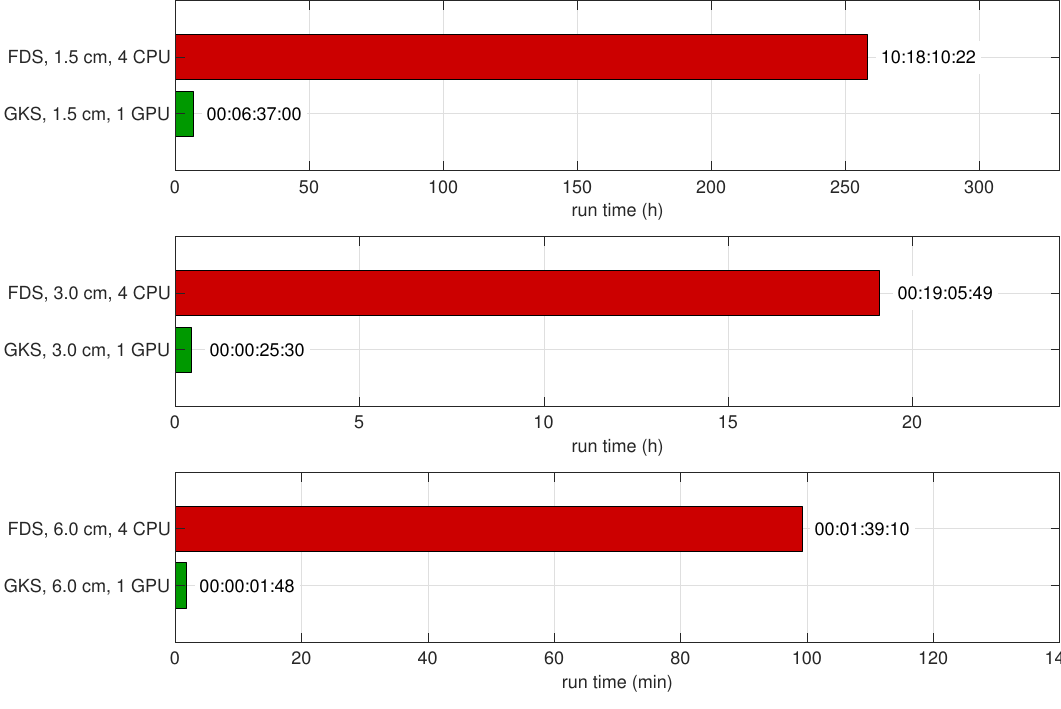
Figure 17. Sandia flame, Test 24: time required for FDS and GKS simulations to simulate flame evolution for 20s. The CPUs used are INTEL Xeon E5-2640v4, and the GPUs used are NVIDIA Tesla